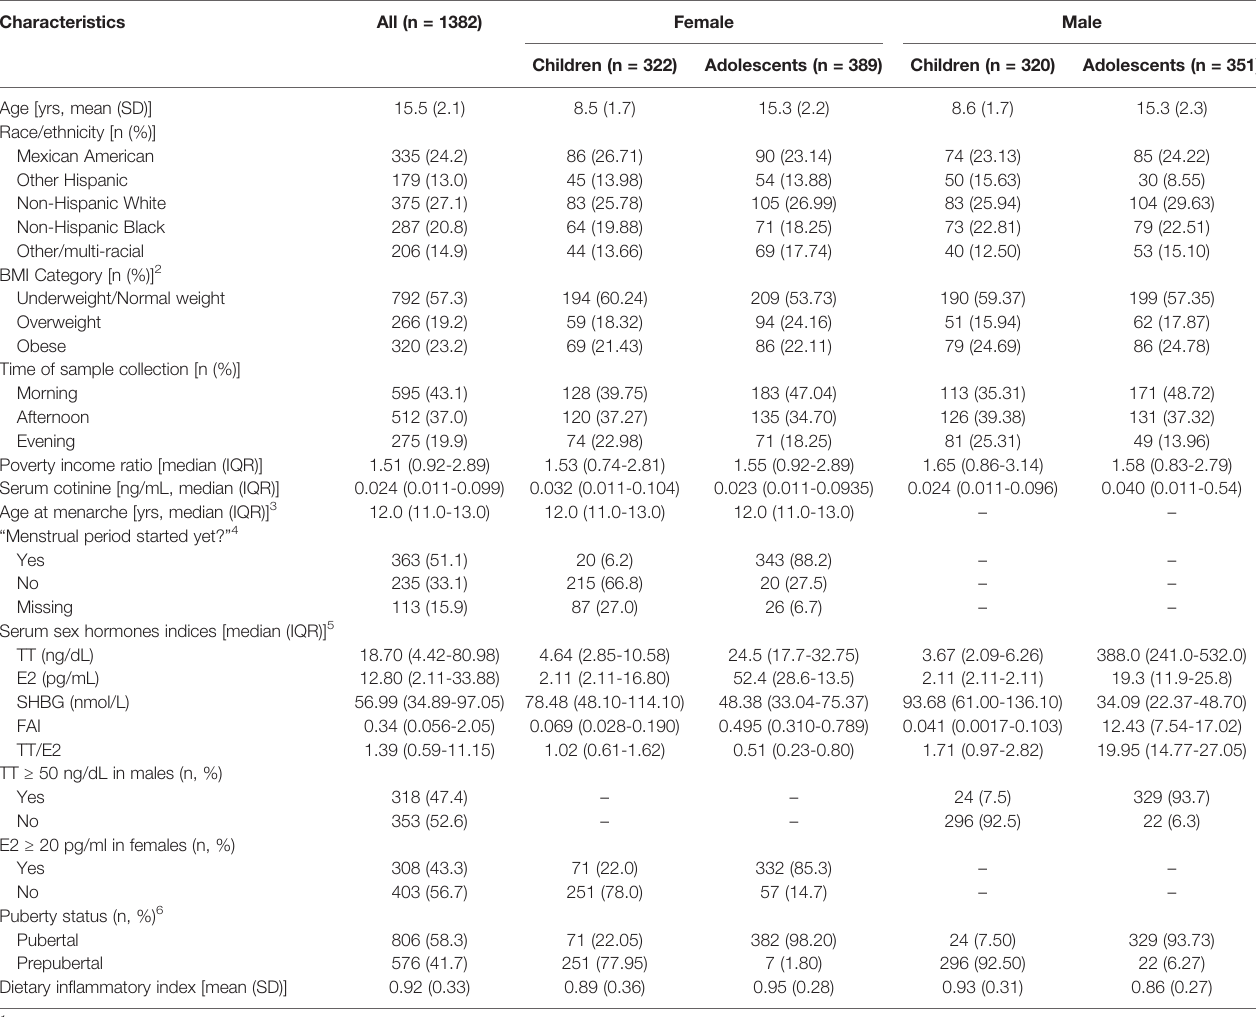
TABLE 1 | Characteristics of 6-19-year old children and adolescents with serum sex hormones and urinary Dietary in fl ammatory index(DII) in NHANES 2015-2016. 1